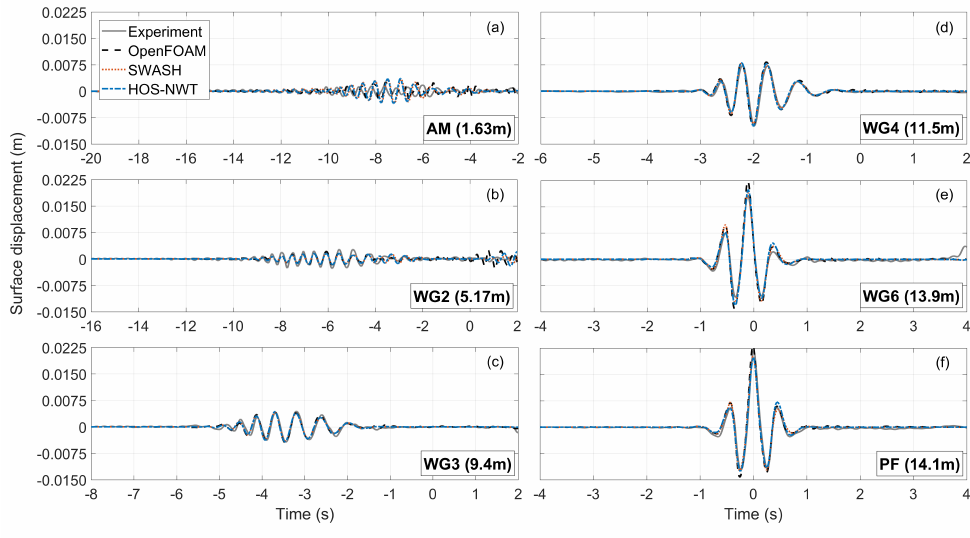
Figure 11. Comparison of the free surface elevation of the 3 rd order harmonics between the numerical models and the experiment at different locations ( a – f